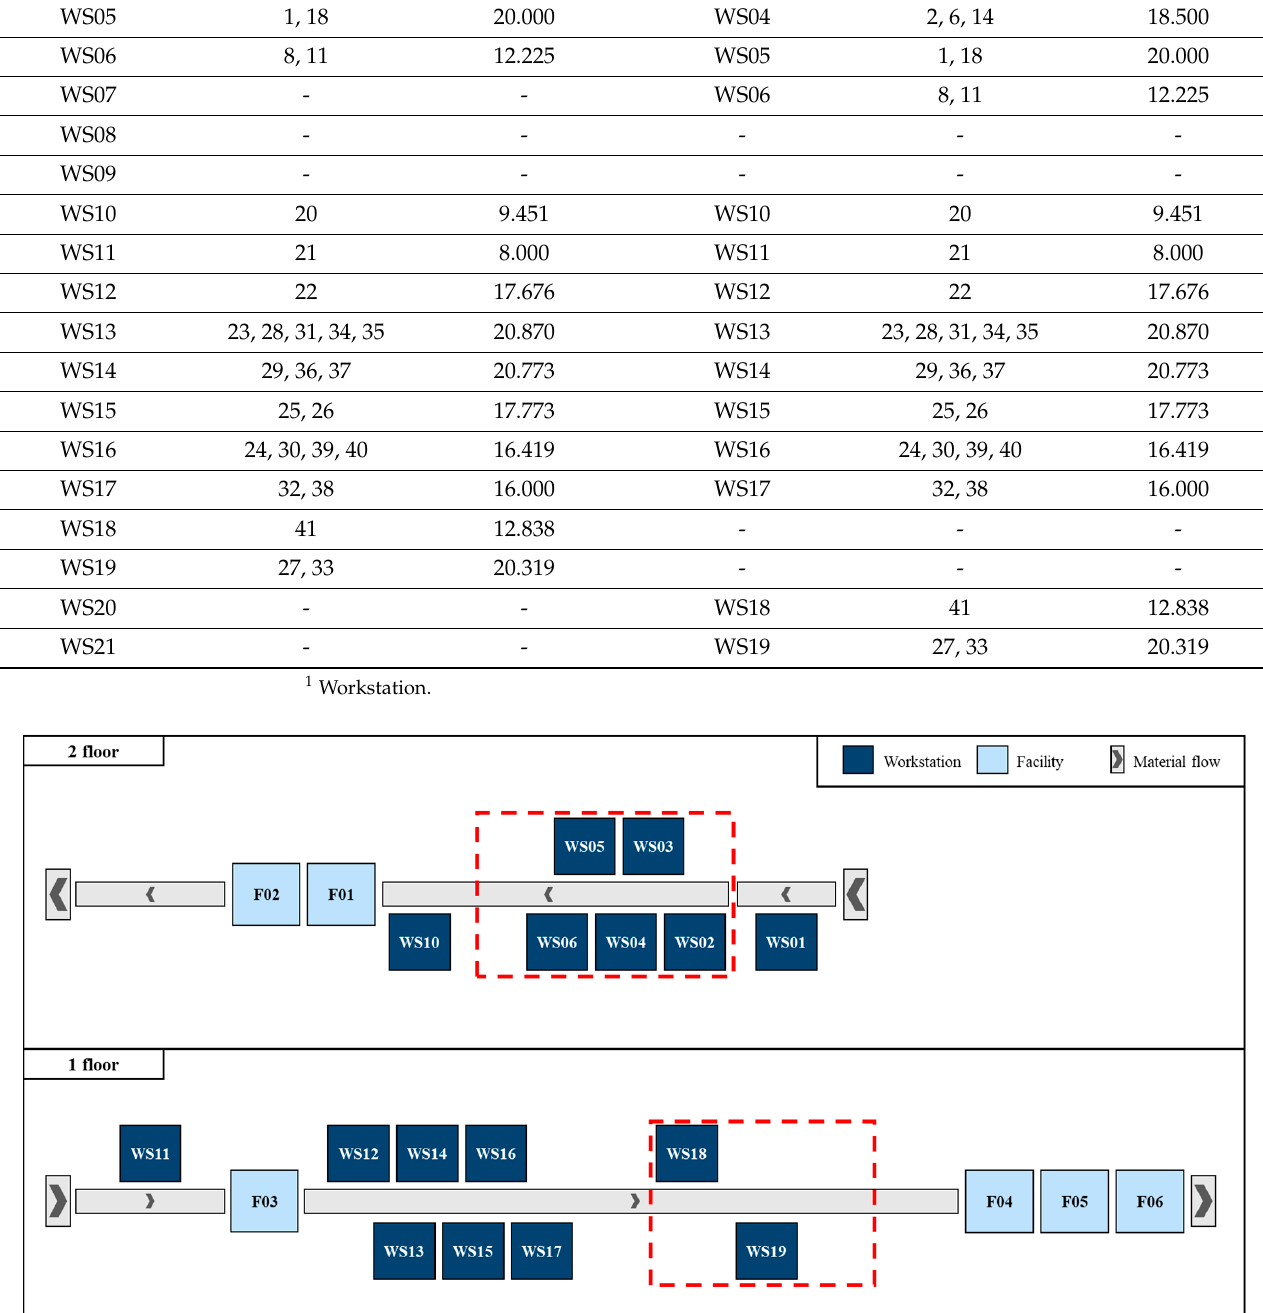
Figure 7. Layout image after optimization.